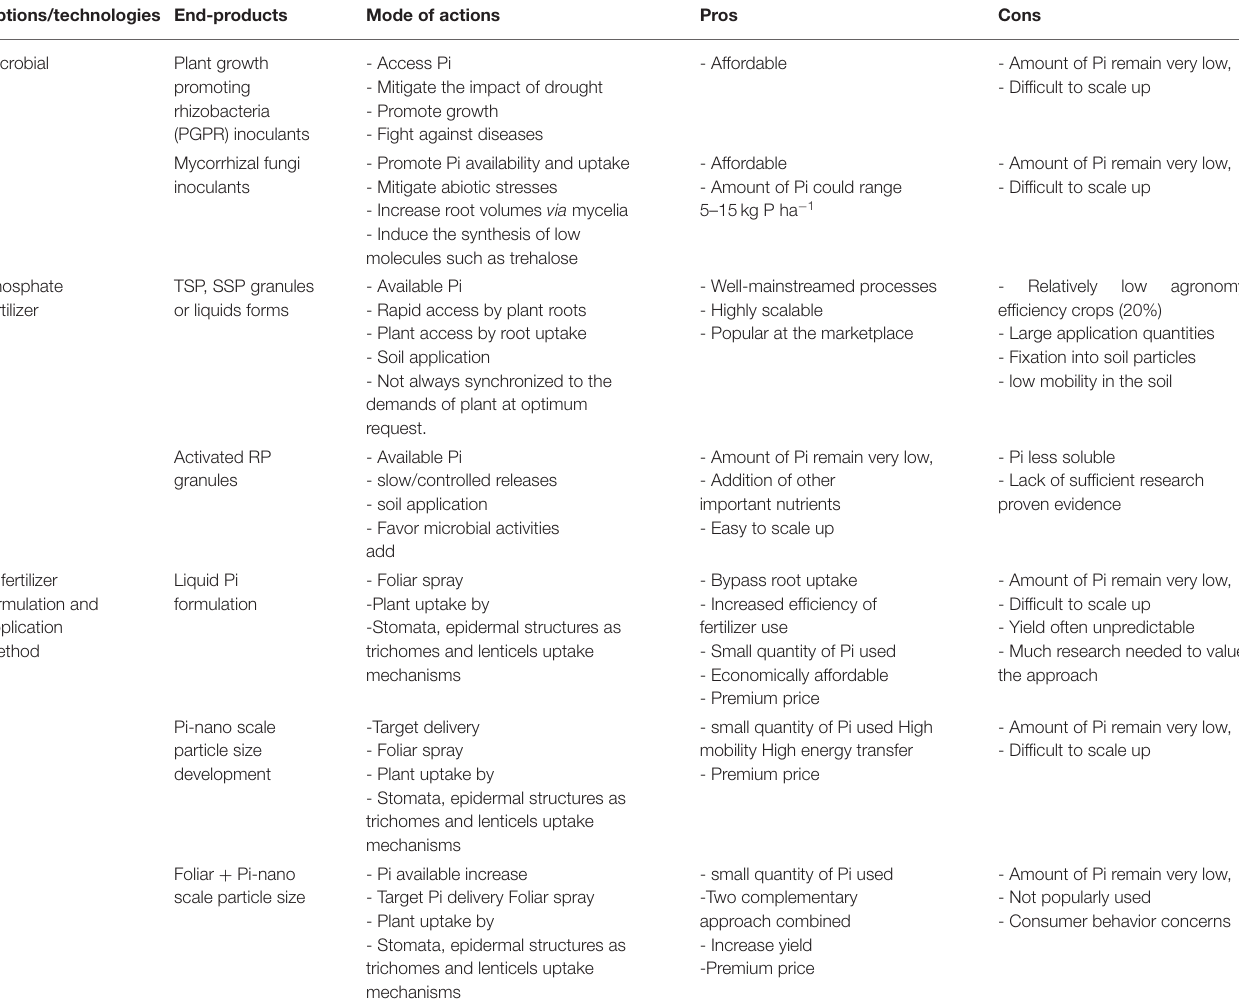
TABLE 2 | Options/technologies, end-products, mode of actions, pros and cons of available P-based innervations to increase growth to mitigate P deficiency, enhancing P use efficiency in plants under abiotic stress conditions. Options/technologies End-products